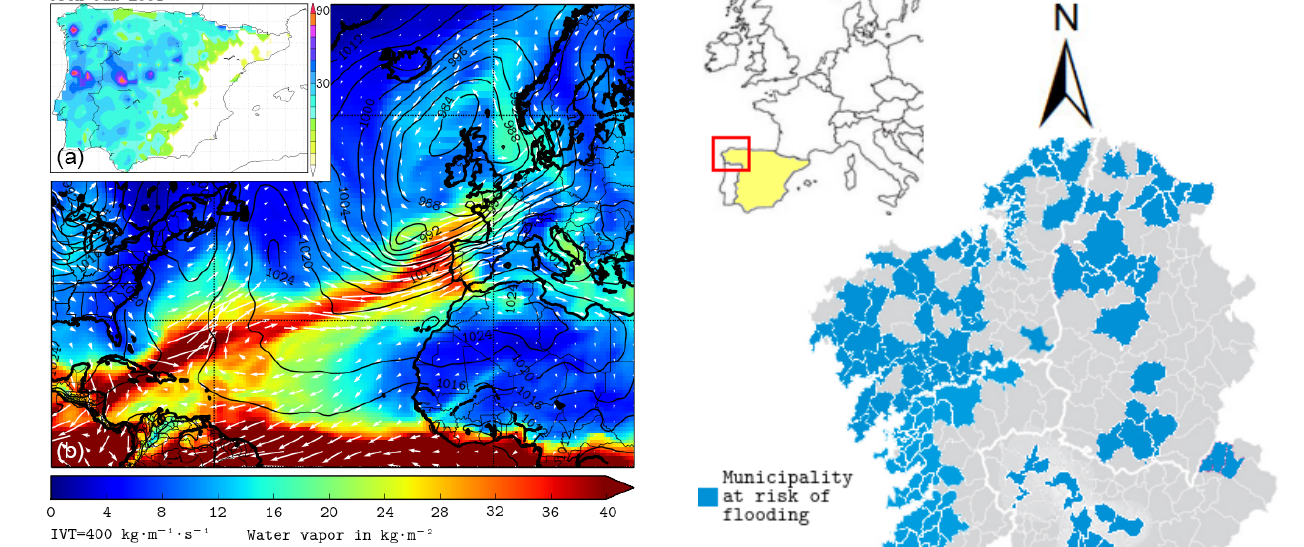
Extreme precipitation and anomalous winds are the most frequent climate risks in Galicia. In coastal towns, floods are more common (Fig. 2) and the corresponding socioeconomic impacts are the most severe (Martínez and Ezpeleta,